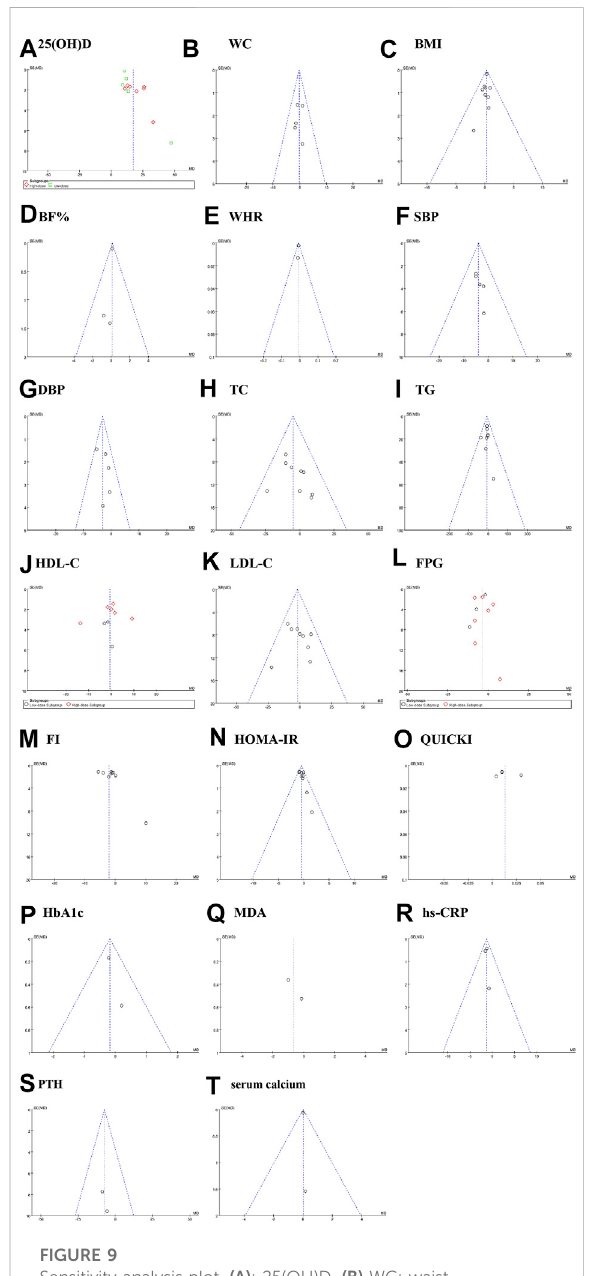
FIGURE 9 Sensitivity analysis plot. (A) : 25(OH)D, (B) WC: